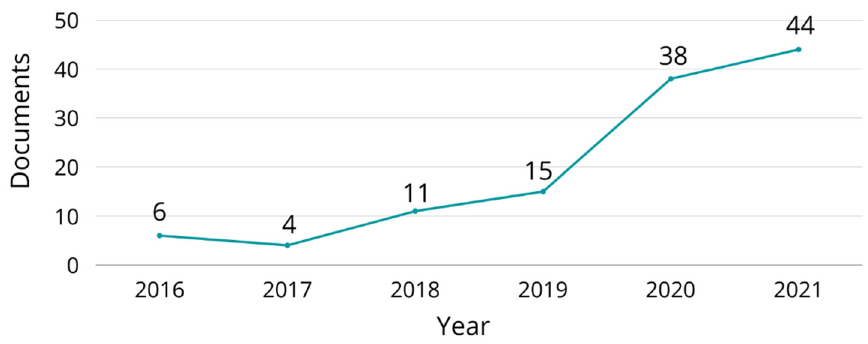
Figure 13. Temporal distribution of the studies where natural fibers was evaluated as possible feedstock in FDM until 2021.